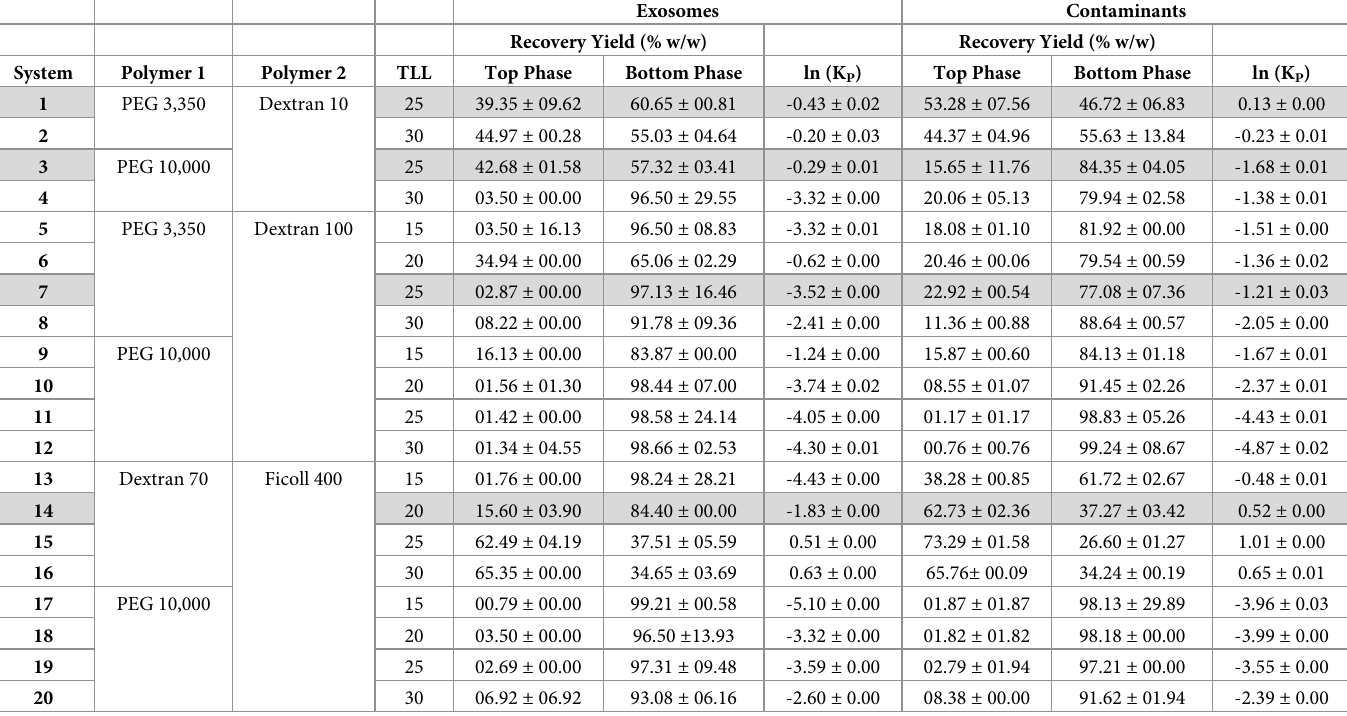
Table 2. Effect of polymer composition, molecular weight (MW) and tie-line length (TLL) upon the partition coefficient, recovery yield and selectivity of exosomes and contaminants in each aqueous two-phase